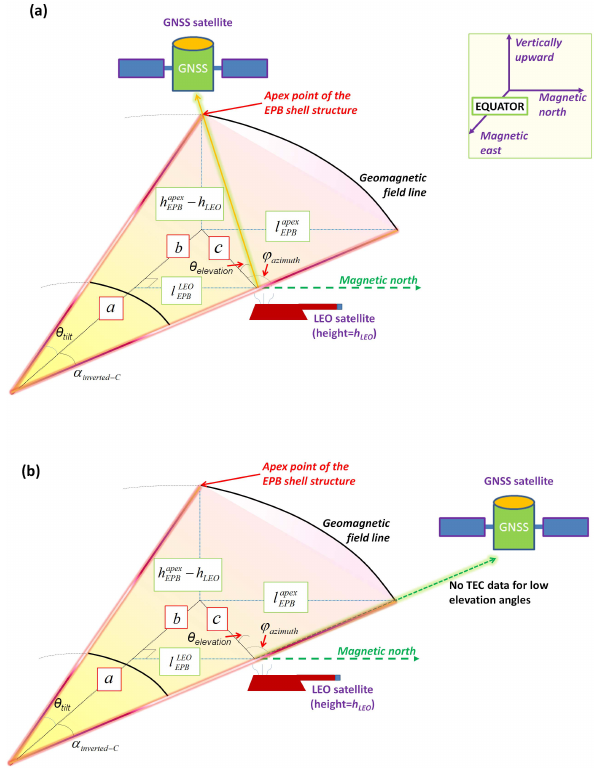
Figure 4. Schematic illustration of the EPB shell structure, in a bird- eye’s view seen from northeast toward the equator: (a) the elevation angle of the GNSS satellite is large, and the LOS between LEO and GNSS satellites passes through the apex point of the EPB shell structure, and (b) the elevation angle of the GNSS satellite is small, and the LOS between LEO and GNSS satellites is nearly horizontal and along the inverted-C